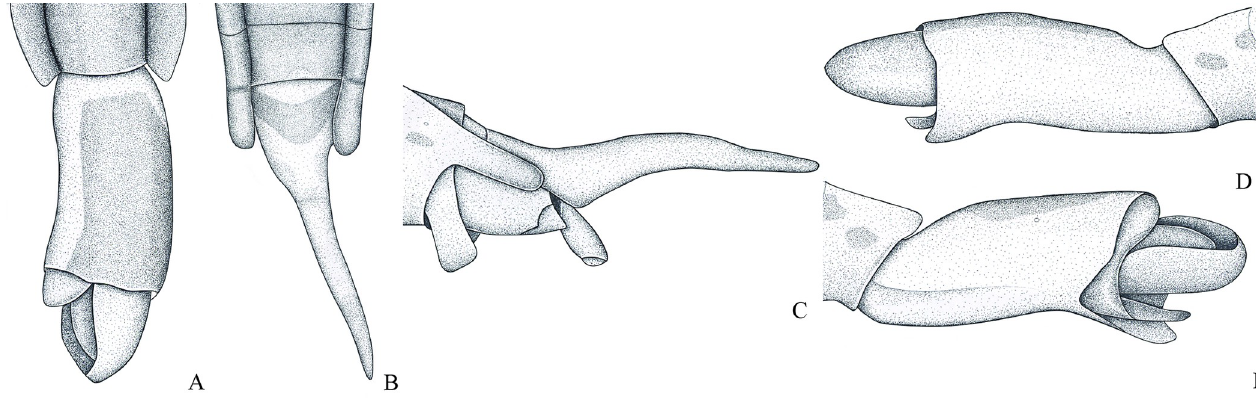
Fig 18. Potamobates molanoi sp. new. (A) Male, terminalia, dorsal view; (B) female, terminalia, dorsal view; (C) female, terminalia, lateral view; (D) male, terminalia, right lateral view; (E) male, terminaia, left lateral view.